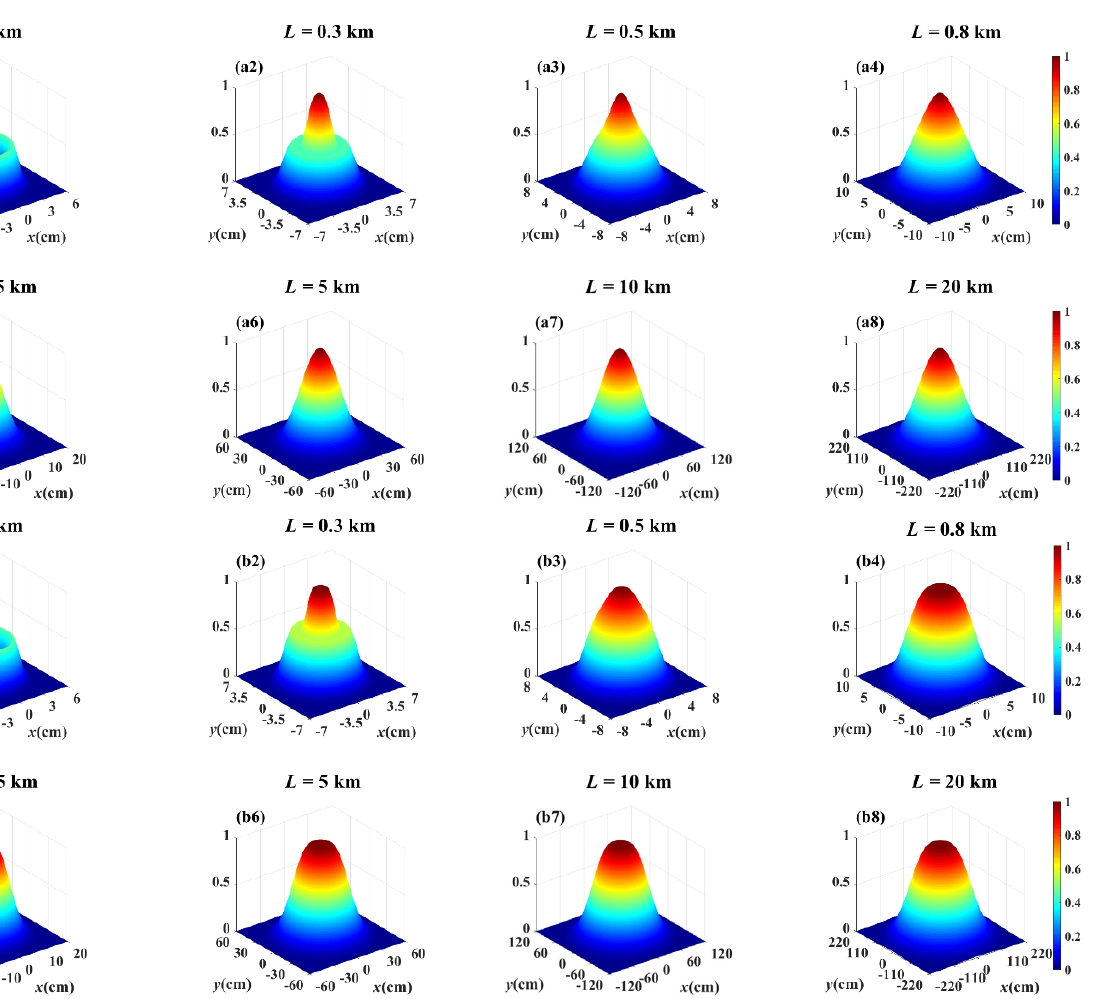
Figure 1. Normalized spectral intensity distribution of ( a1 – a8 ) the PCLGP beam and ( b1 – b8 ) the PCTLGP beam at several propagation distances in anisotropic turbulence ( ξ x = ξ y = 3, l = 1, n = 1, C ̃ 2 n = 1 × 10 − 14 m 3 − α ).